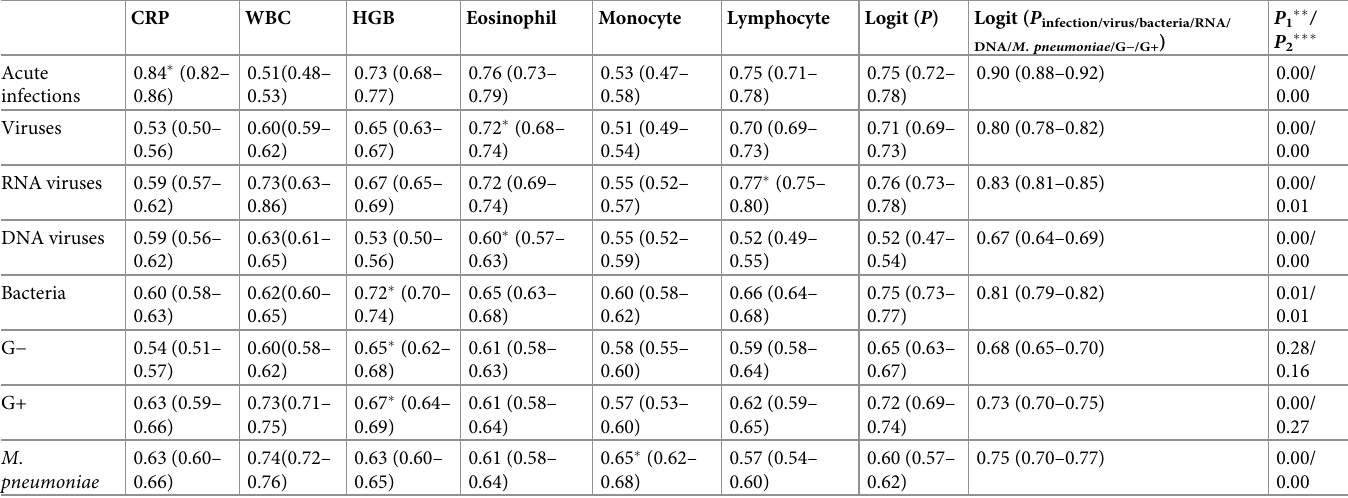
Table 2. AUROC values of significant parameters, logit ( P ), and logit ( P control/virus/bacteria/RNA/DNA/M. pneumoniae/G − /G+